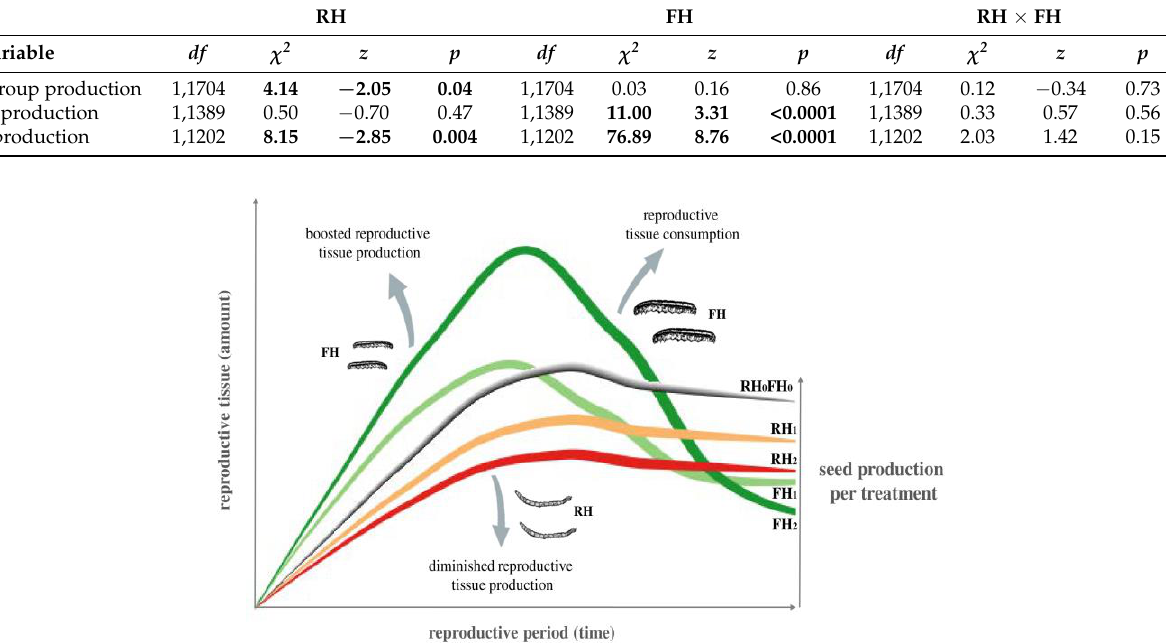
Figure 1. Illustrative representation of the temporal dynamics of plant reproductive tissue production and reproductive tissue loss throughout the reproductive period up to the number of seeds produced when interacting with different densities (0—absence, 1—low, 2—high) of root herbivores (RH) and floral herbivores (FH). Left side y axis encompasses the general pattern observed for the reproductive tissues: floral bud groups, flowers, and fruits.